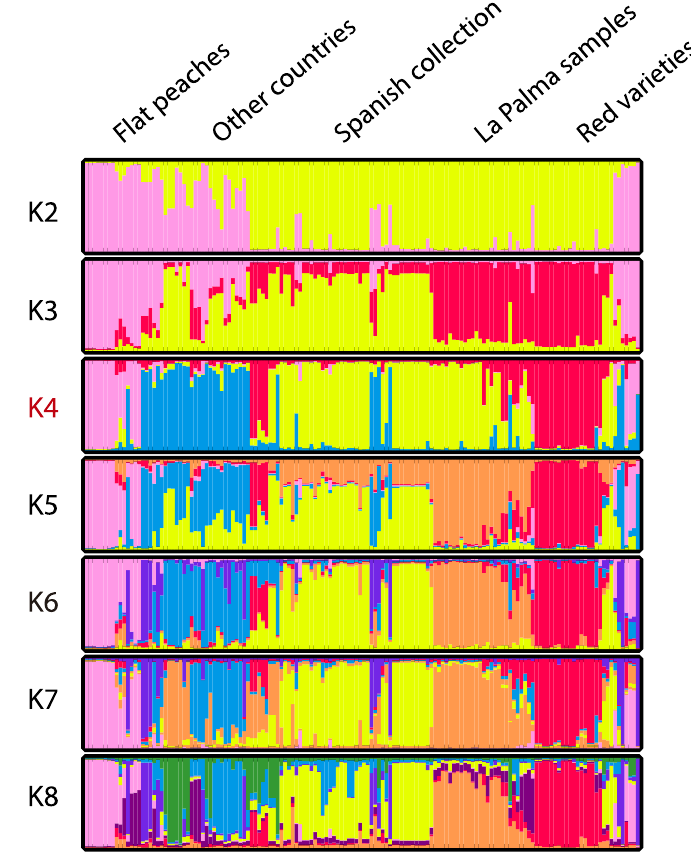
Figure 4. Structure results of the peach samples analyzed with 50 repetitions (for Q = 10 × 5 repetitions) for k = 2 to k = 8. The number of populations assigned by Evanno (4) is highlighted in red.